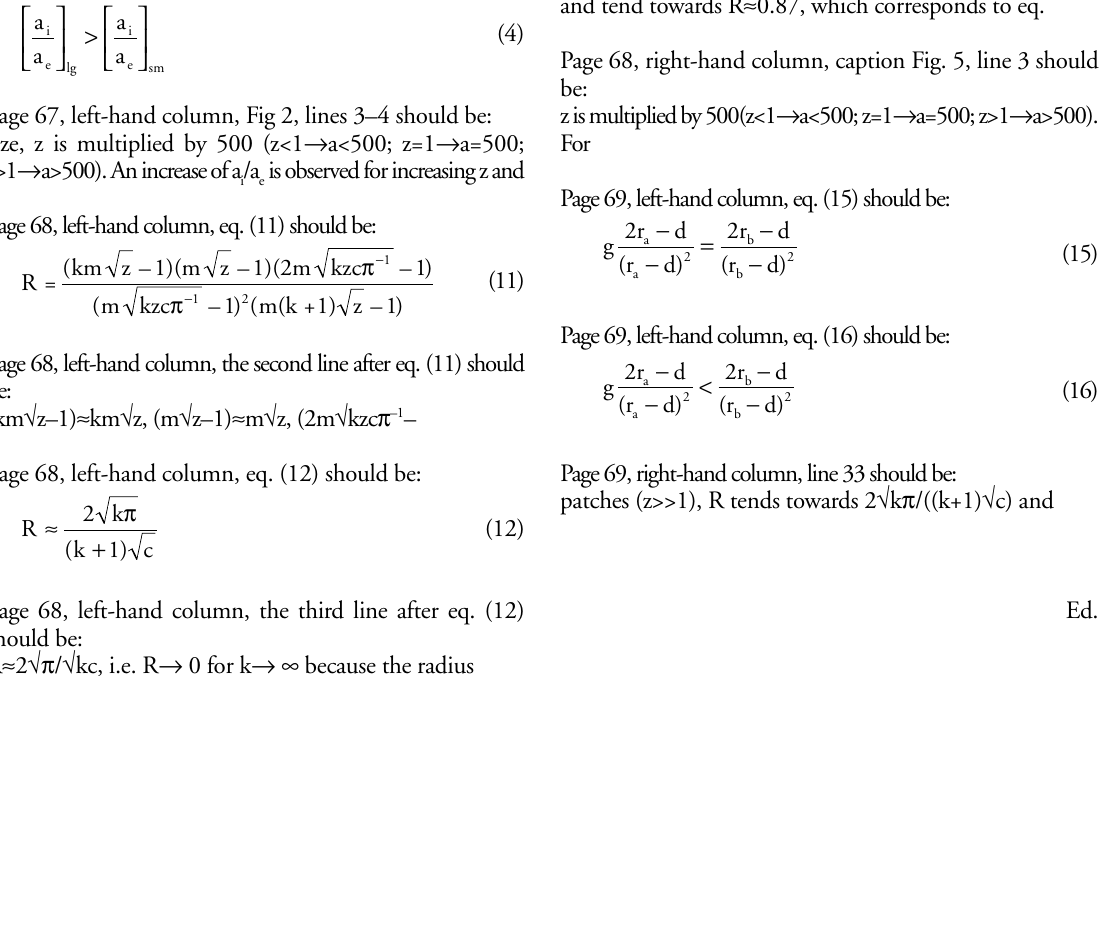
Page 68, right-hand column, line 1 should be: and tend towards R ≈ 0.87, which corresponds to eq. Page 68, right-hand column, caption Fig. 5, line 3 should be: For Page 69, left-hand column, eq. (15) should be: